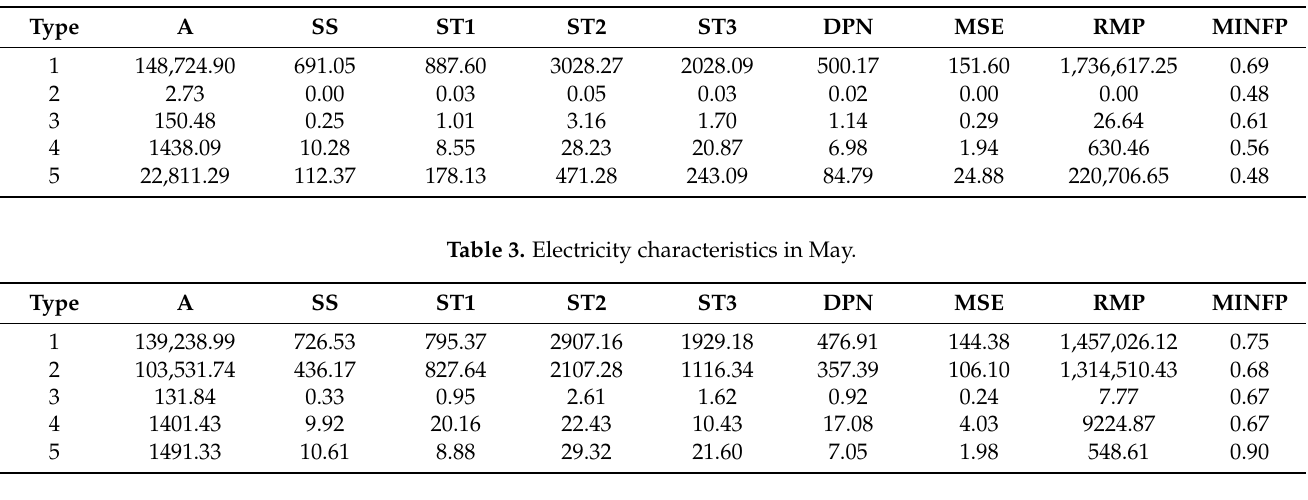
tumn), and in May and November (summer and winter) were consistent, respectively.